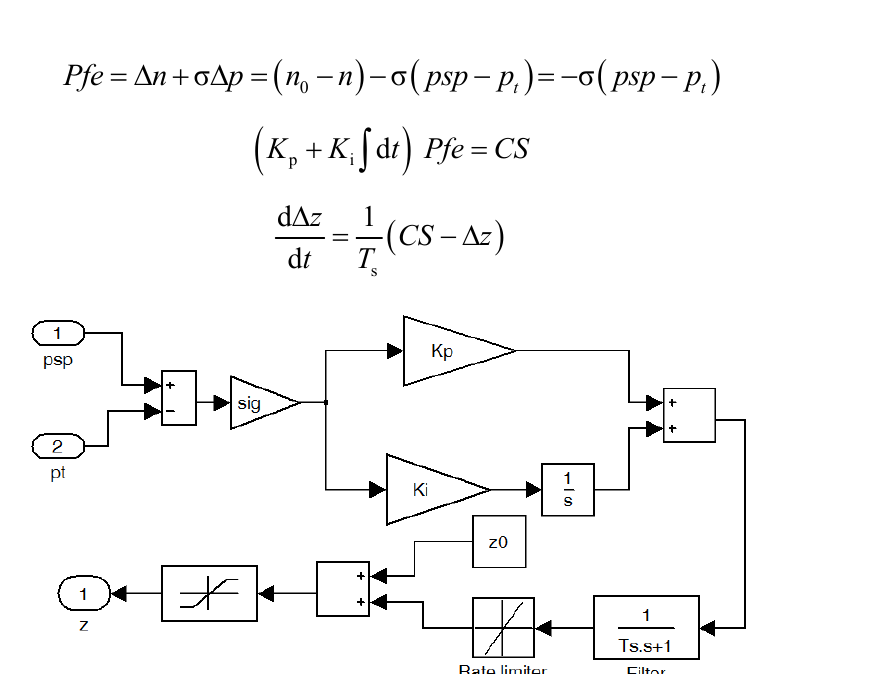
Figure 4. Block diagram of the turbine